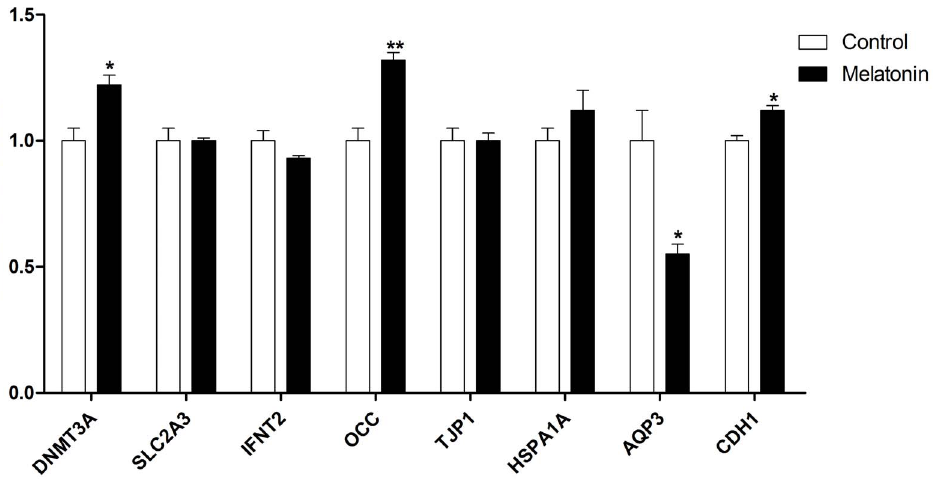
Figure 3. Effects of melatonin on the gene expression of developmentally important genes. Eight developmentally important genes (DNMT3A, SLC2A3, IFNT2, OCC, TJP1, HSPA1A, AQP3, CDH1) were detected in bovine blastosyst after thawing. The letters of a and b represent statistically significant differences (P , 0.05).